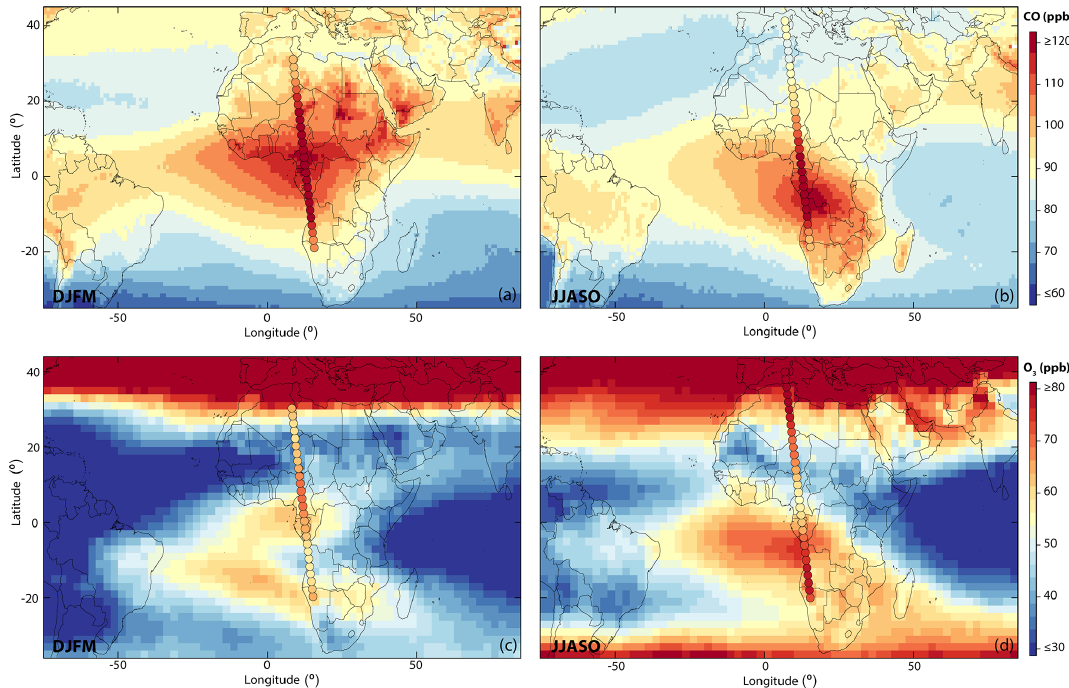
Figure 5. Seasonal mean IASI CO (a, b) and O 3 (c, d) mixing ratios at 253hPa between 2008 and 2013. The points represent IAGOS measurements averaged over all studied